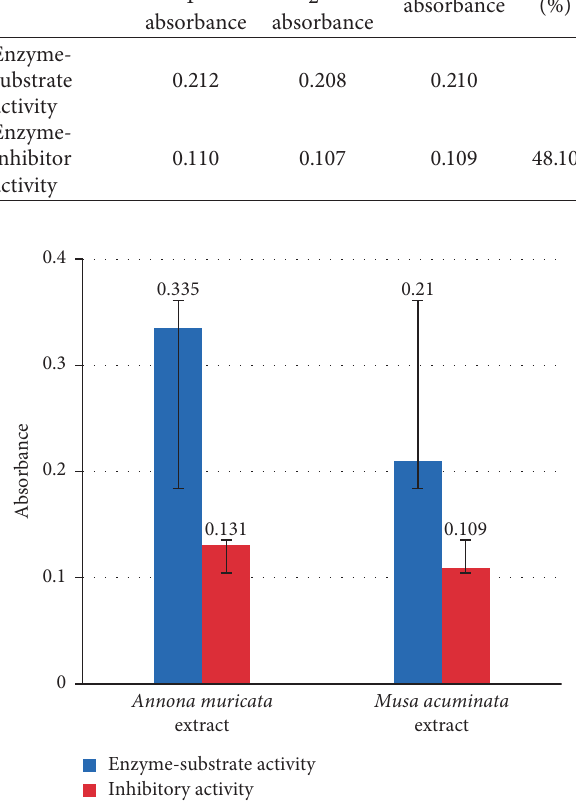
Figure 4: Enzymatic activities and variation of inhibitory activities with